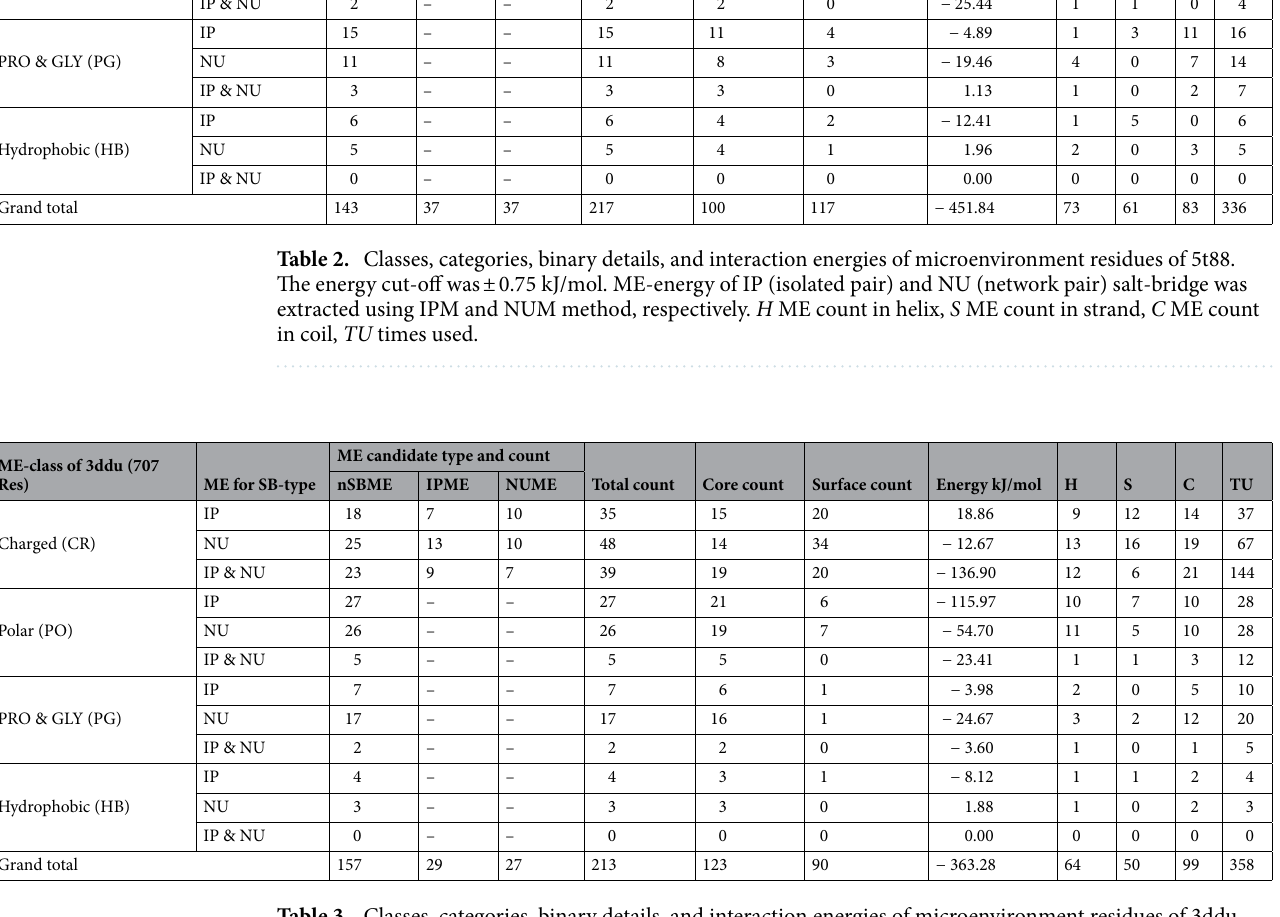
Table 3. Classes, categories, binary details, and interaction energies of microenvironment residues of 3ddu. The energy cut-off was ± 0.75 kJ/mol. ME-energy of IP (isolated pair) and NU (network pair) salt-bridge